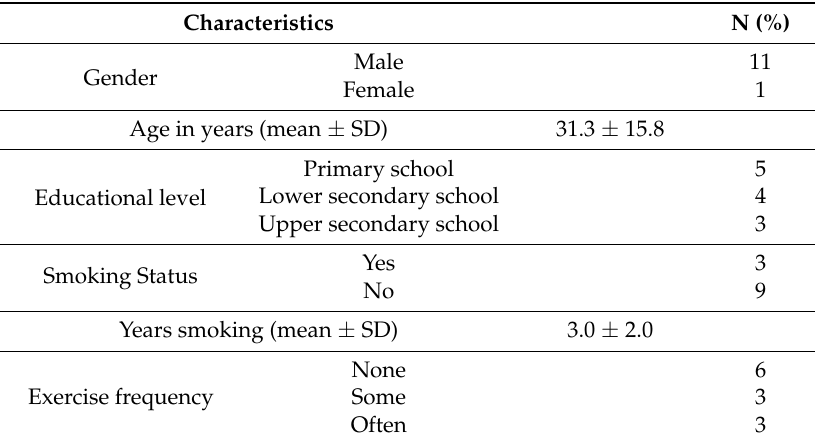
Table 1. Demographic information (SD = Standard deviation).